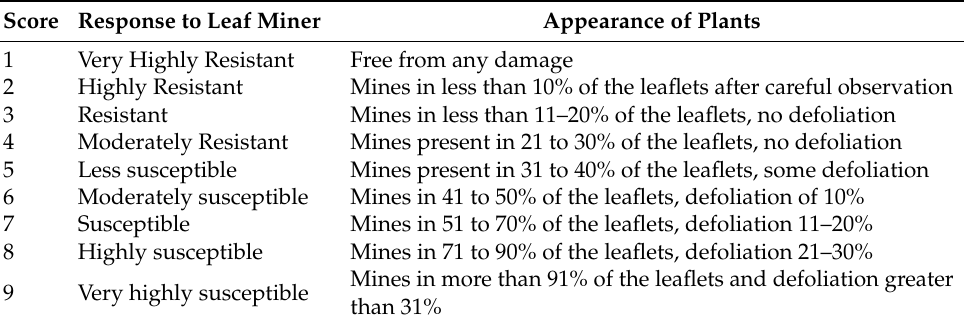
Table 1. Visual 1–9 scale for resistance to chickpea leafminer in RILs derived from interspecific crosses between C. arietinum and C.